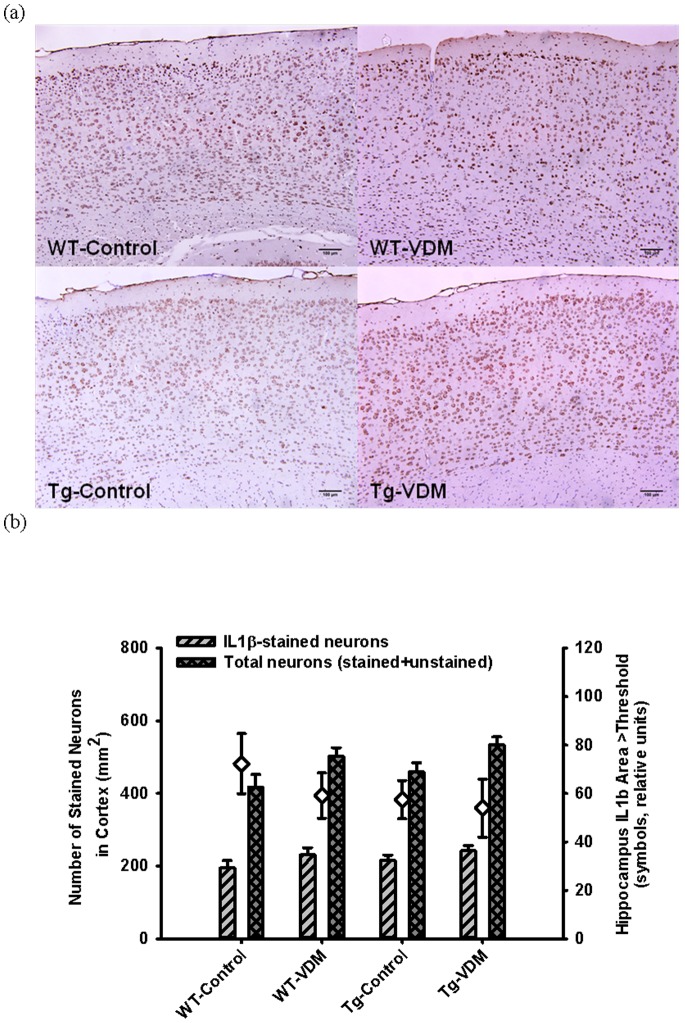
Immuno-histochemical quantification of IL-1β-stained brain areas at 9 months.Typical images of IL-1β-stained brains comparing mouse study groups (a) and results of quantitation by image analysis for the total cortex (neocortex plus temporal cortex, bars) and hippocampus (symbols) regions (b). Two way ANOVA analysis indicated no significant effects of either feed type or genotype on IL-1β-stained neuron area but a significant main effect of feed on total neuron number (P<0.05).